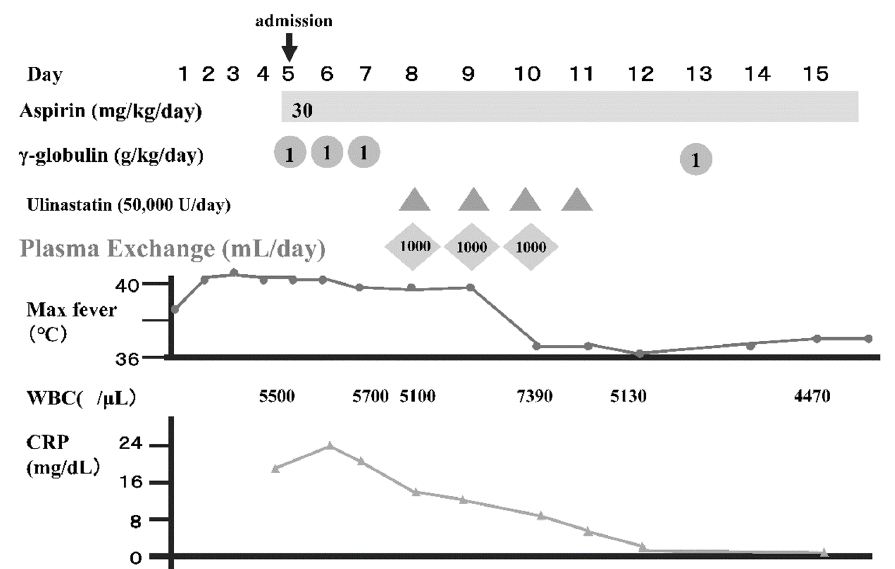
Figure 1. Clinical course of a 2-year-old boy with PE treatment.